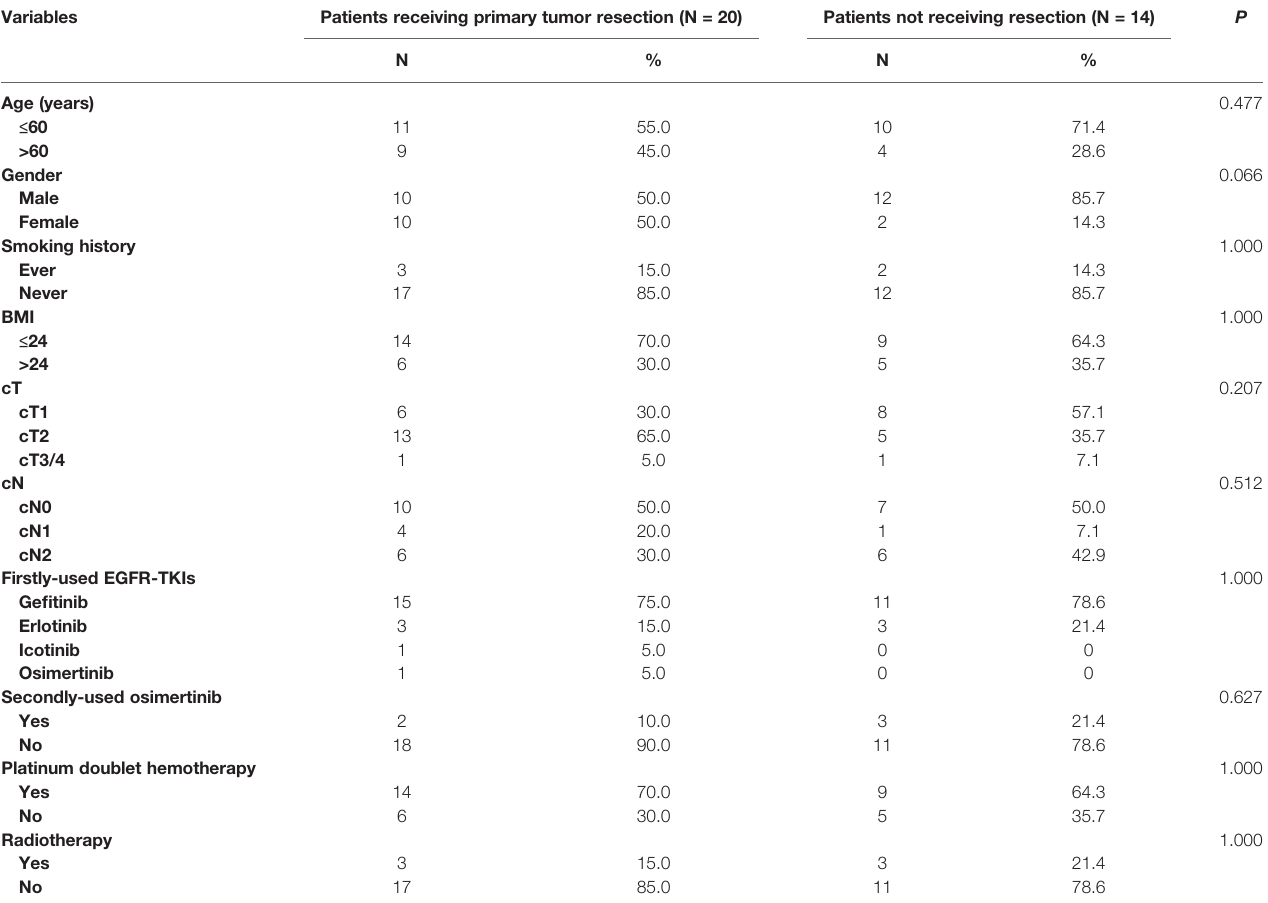
TABLE 2 | Clinicopathologic characteristics of patients receiving and not receiving primary lesion resection.